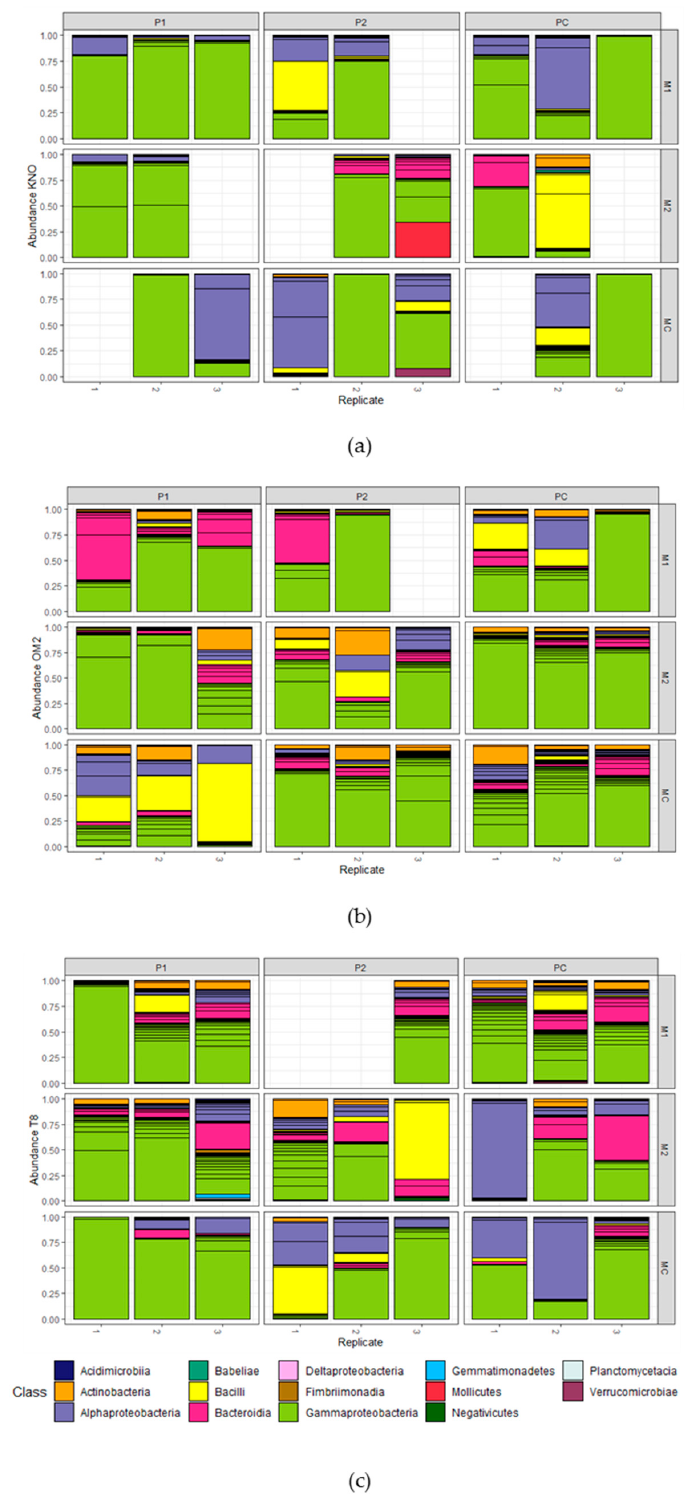
Figure 5. Gut microbial composition of Daphnia in the microbiome transplant experiment. OTU relative abundances are portrayed for ( a ) the KNO genotype, ( b ) the OM2 genotype, and ( c ) the T8 genotype. Recipient populations are grouped per multifactorial combination of microbiome and parasite community. Colors indicate the bacterial class. OTUs with a relative abundance lower than 1% are not included. Each bar represents one sample containing gut material of one to six recipients which was pooled for